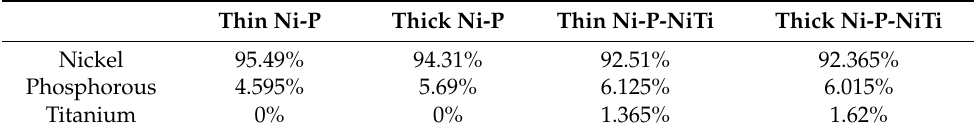
Figure 2. Thick Ni-P-NiTi cross-sectional EDS map. ( a ) Map including Ni, P, and Ti. ( b ) Map showing Ti exclusively. Table 3. Coating Compositions from EDS Analysis.